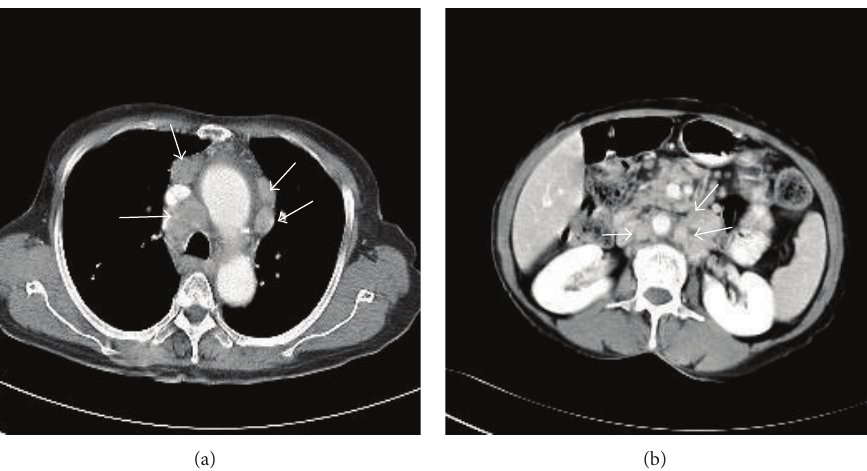
Figure 1: (a) A chest CT shows multiple enlarged lymph nodes in mediastinum. (b) An AP CT reveals multiple enlarged lymph nodes in abdominal retroperitoneal space. (White arrows: enlarged lymph nodes.)